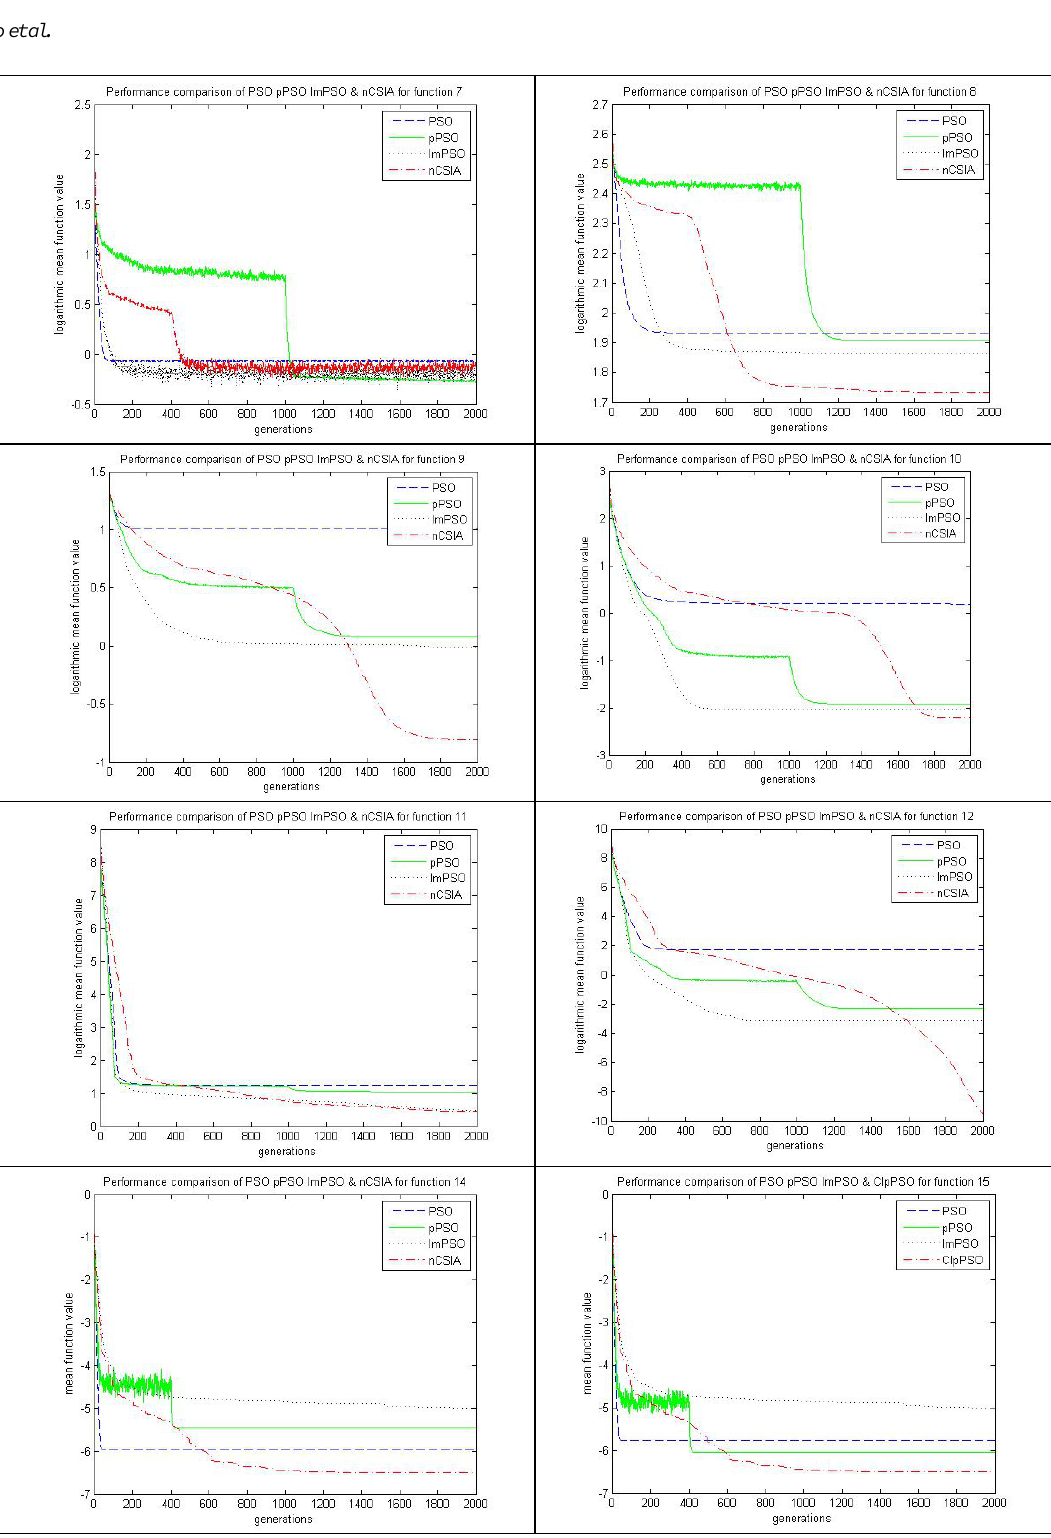
Fig. 3. PSO, pPSO, ImPSO & nCSIA online performance